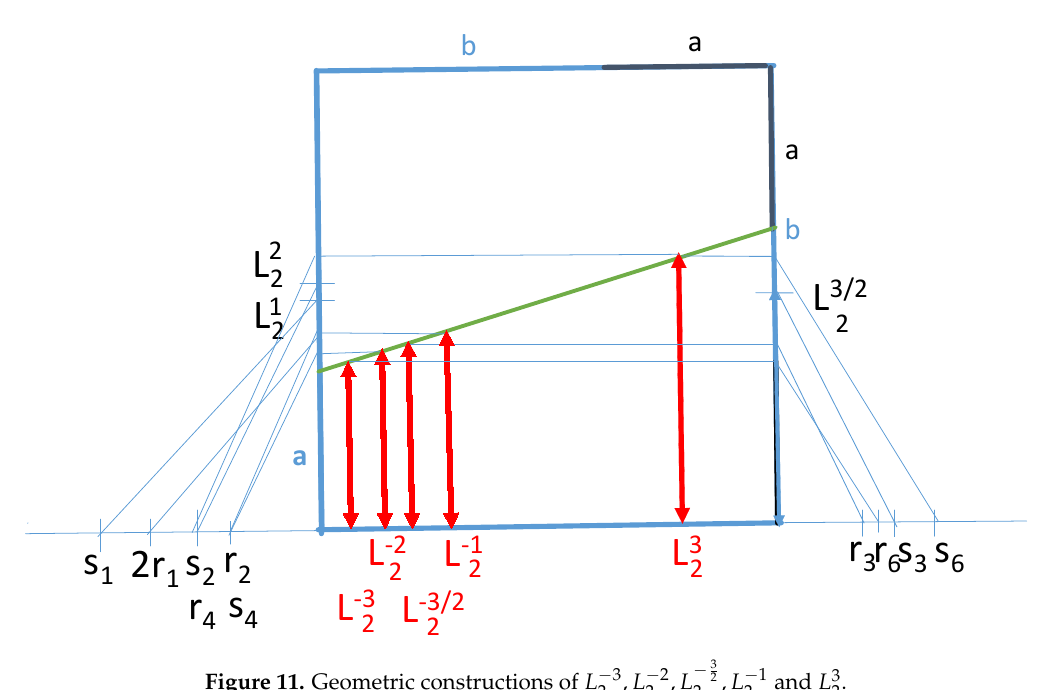
Figure 11. Geometric constructions of L − 3